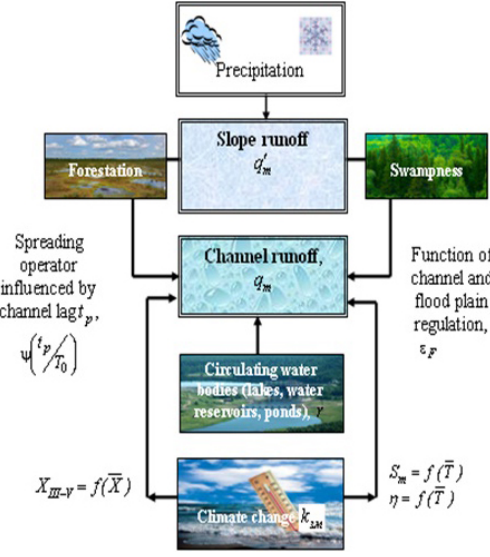
Figure 1. Block diagram of maximal runoff